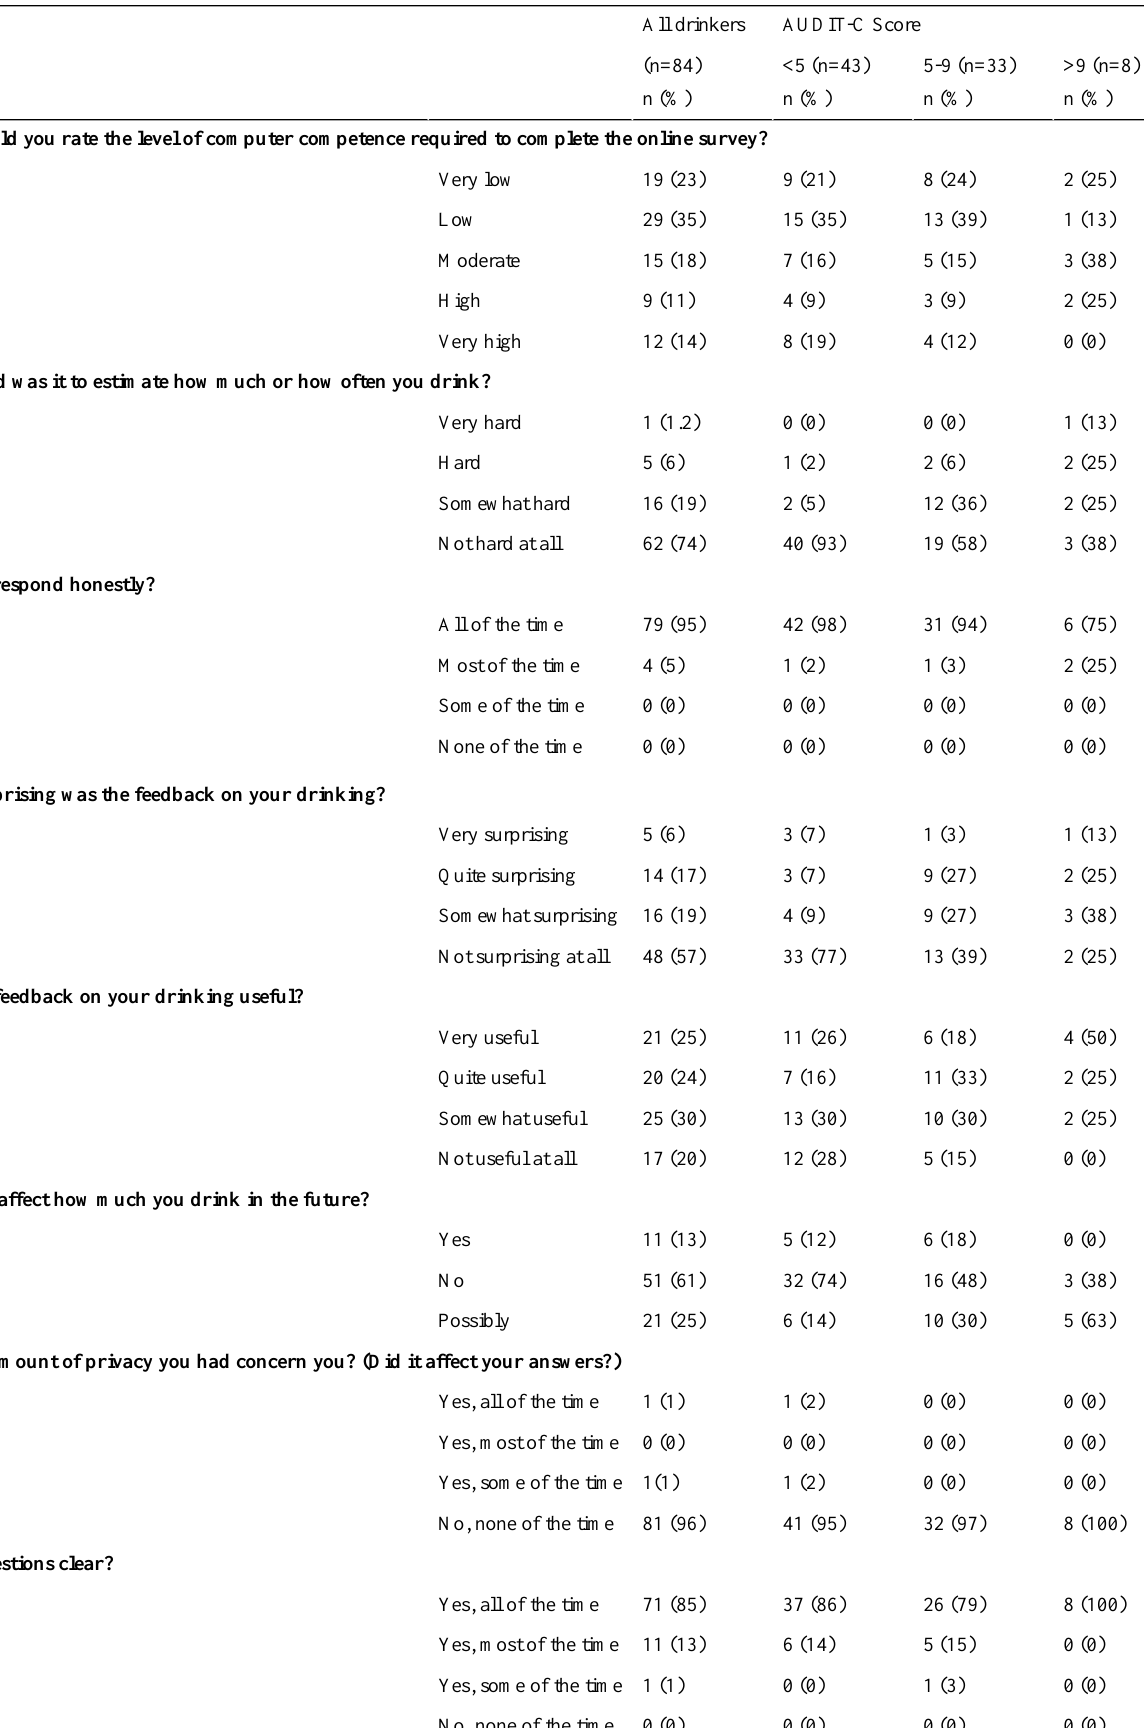
Table 2. Acceptability of e-SBI.